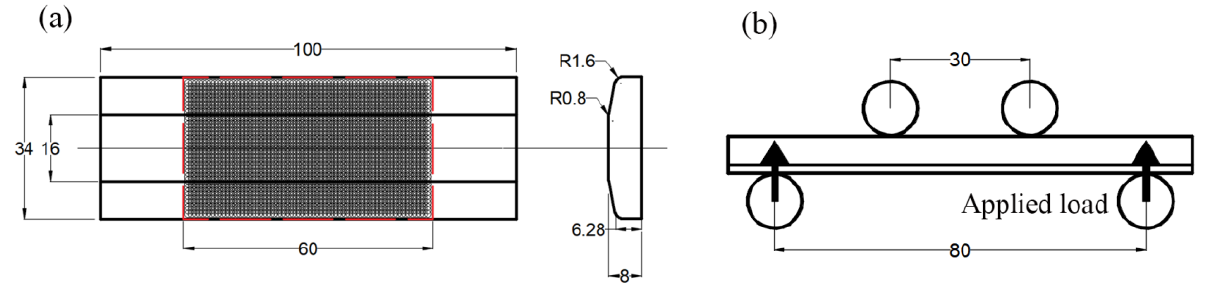
Figure 1. ( a ) Dimensions of the specimen with the illustration of laser peened region; ( b ) schematic diagram of four-point bend fatigue test set-up.